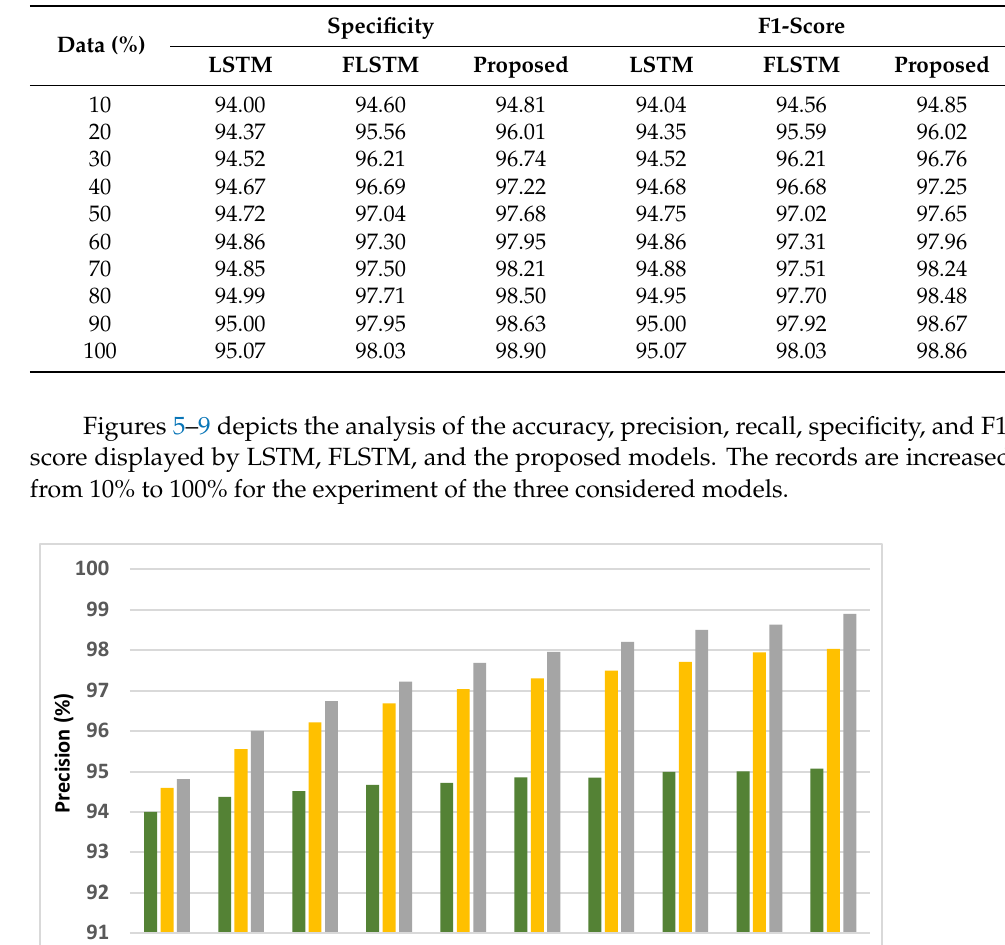
Table 5. Performance measures of specificity and F1-score.